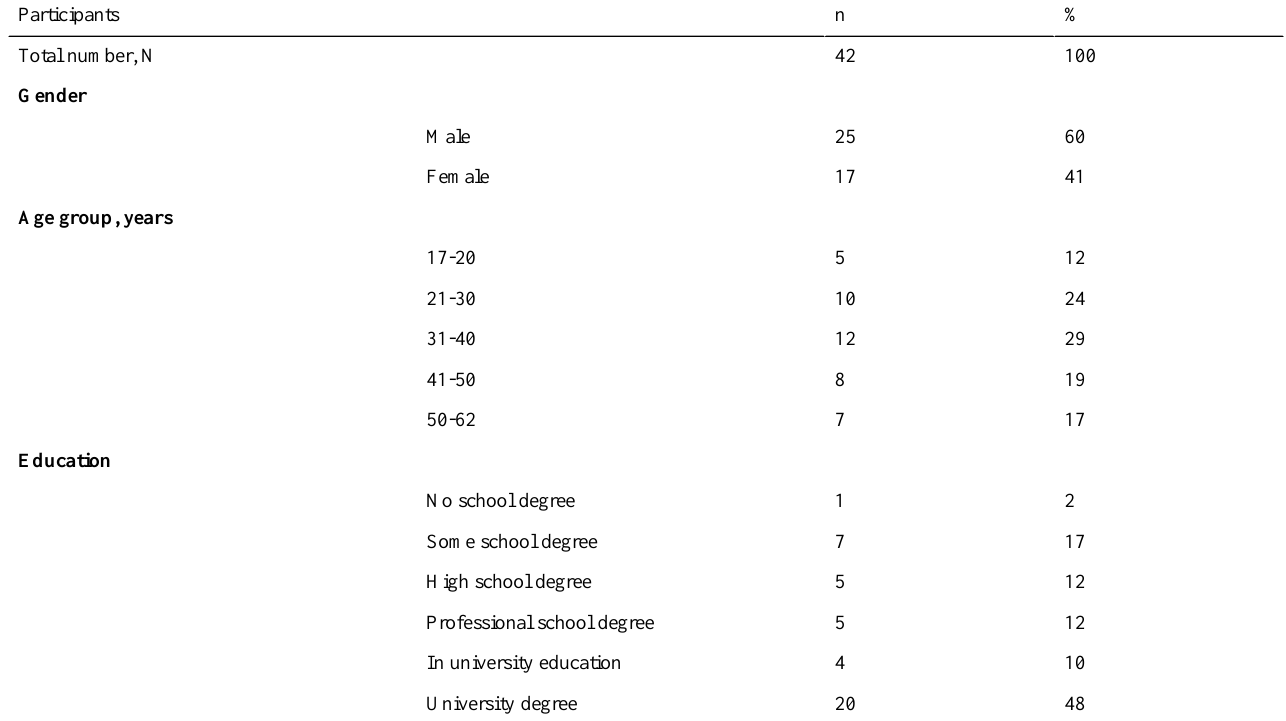
Table 2. Detailed sample description of the observational study,